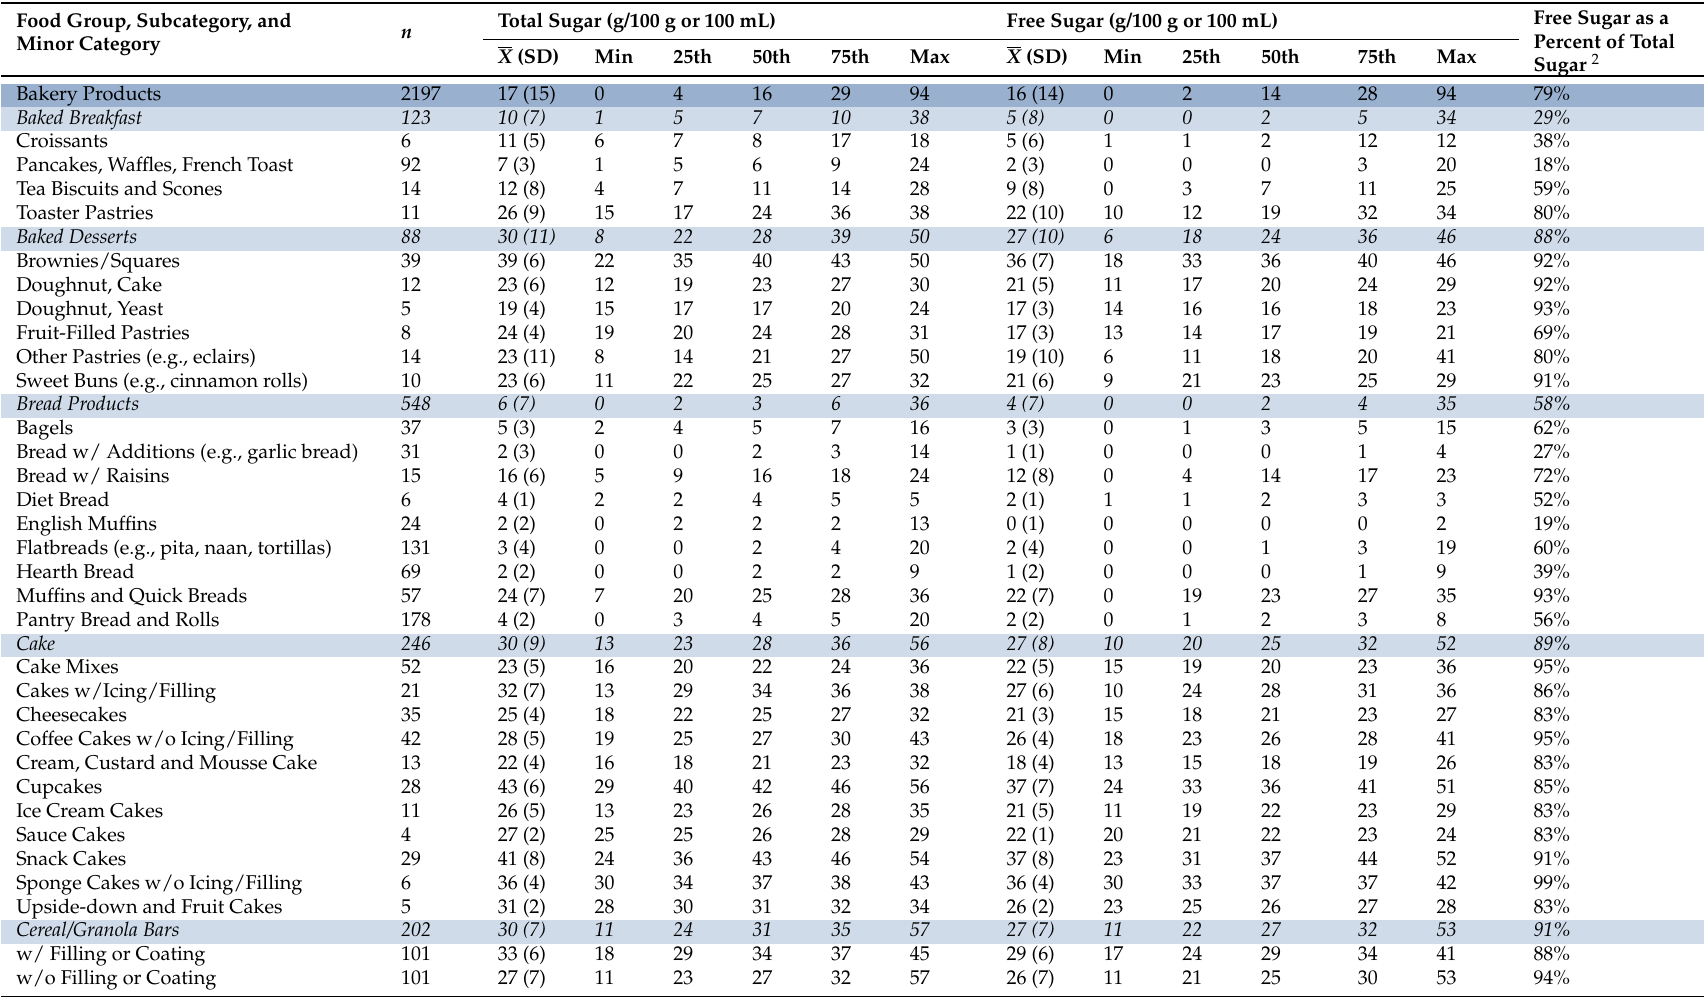
Table 3. Total and free sugar contents (g per 100 g or 100 mL) and average free sugar as a proportion of total sugar (%) in FLIP 2013 by food group, subcategory, and minor category ( n = 15,259) 1